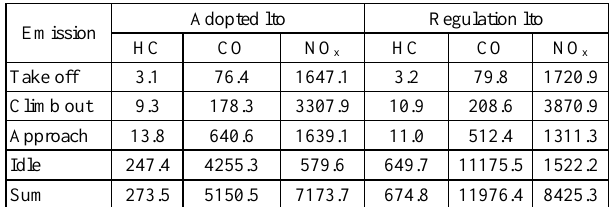
Table 4. Emission toxic exhaust fumes for Boeing 737-400 in